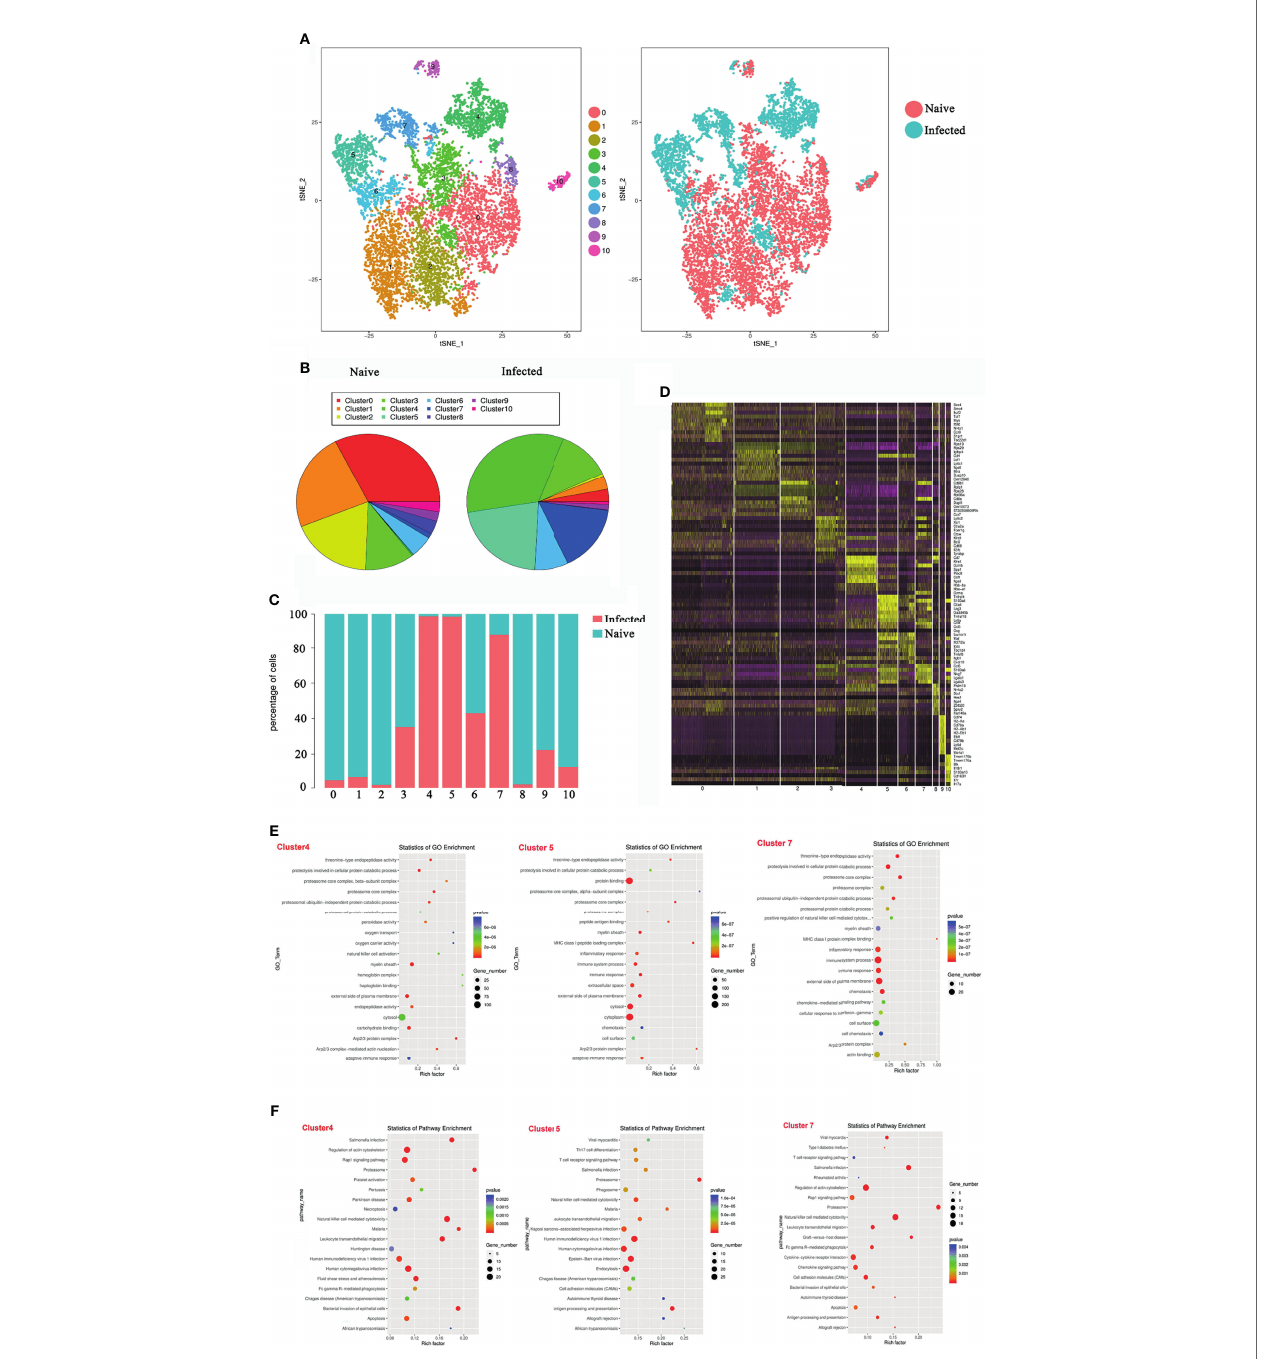
FIGURE 3 | Single-cell transcriptomic analysis of splenic gd T cells from P. yoelii NSM infected mice. At 14 days after P. yoelii NSM infection, splenocytes were isolated from both naive and infected C57BL/6 mice. CD3 + gd TCR + cells were sorted using FACS, and the expression pro fi le in single cells was detected using single-cell RNA sequencing (10× Genomics Chromium system). (A) t-distributed stochastic neighbour embedding visualization (t-SNE). All isolated gd T cells were classi fi ed into 11 clusters according to the properties of the RNA expression pro fi le in each cell. Different colours represent different clusters, as indicated by the label (left ). The cells from naive (red point) or infected (blue point) mice in each cluster are shown ( right ). (B) The percentage of cells in each cluster from naive ( left ) or infected ( right ) mice. (C) The ratio of each cluster in gd T cells from naive (blue) or infected (red) mice. (D) The heatmap of marker genes in each cell cluster. (E) The top 20 signi fi cant GO terms for the marker genes from 4, 5 and 7 cluster. The GO enrichment analysis revealed that the marker genes in each cluster were involved in innate and adaptive immunity. The left represents the GO term, the right represents enrichment, and the size of the solid circle indicates the number of genes. (F) The top 20 signi fi cant KEGG pathways for the marker genes from 4, 5 and 7 cluster. The KEGG pathway of marker genes in each cluster. The left represents the KEGG pathway, the right represents enrichment, and the size of the solid circle indicates the number of genes. A single experiment was performed for scRNA